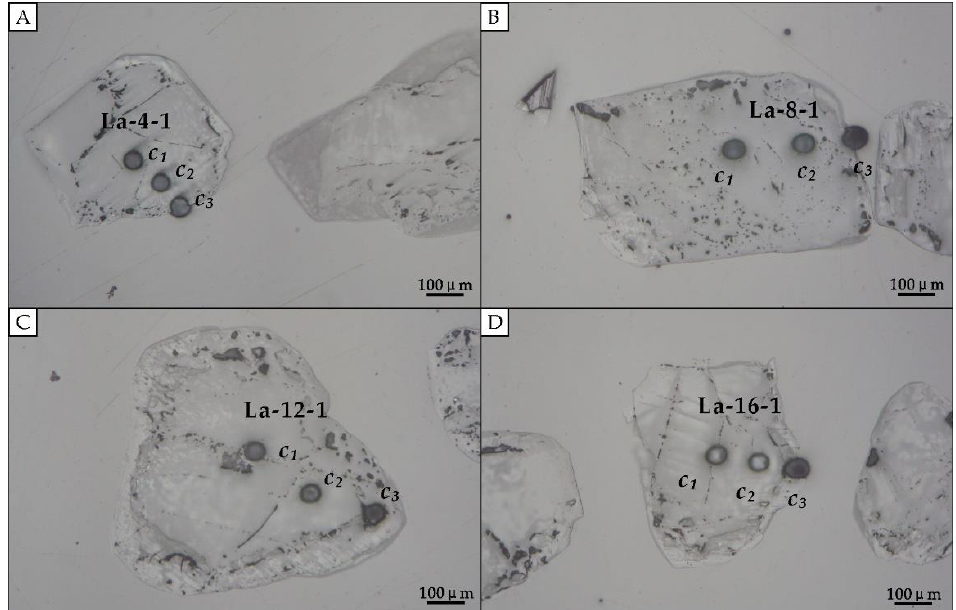
Figure 2. Location of trace element analysis in the micro area in situ. ( A ): location of La-4 grain 1, ( B ): location of La-8 grain 1, ( C ): location of La-12 grain 1, ( D ): location of La-16 grain 1.